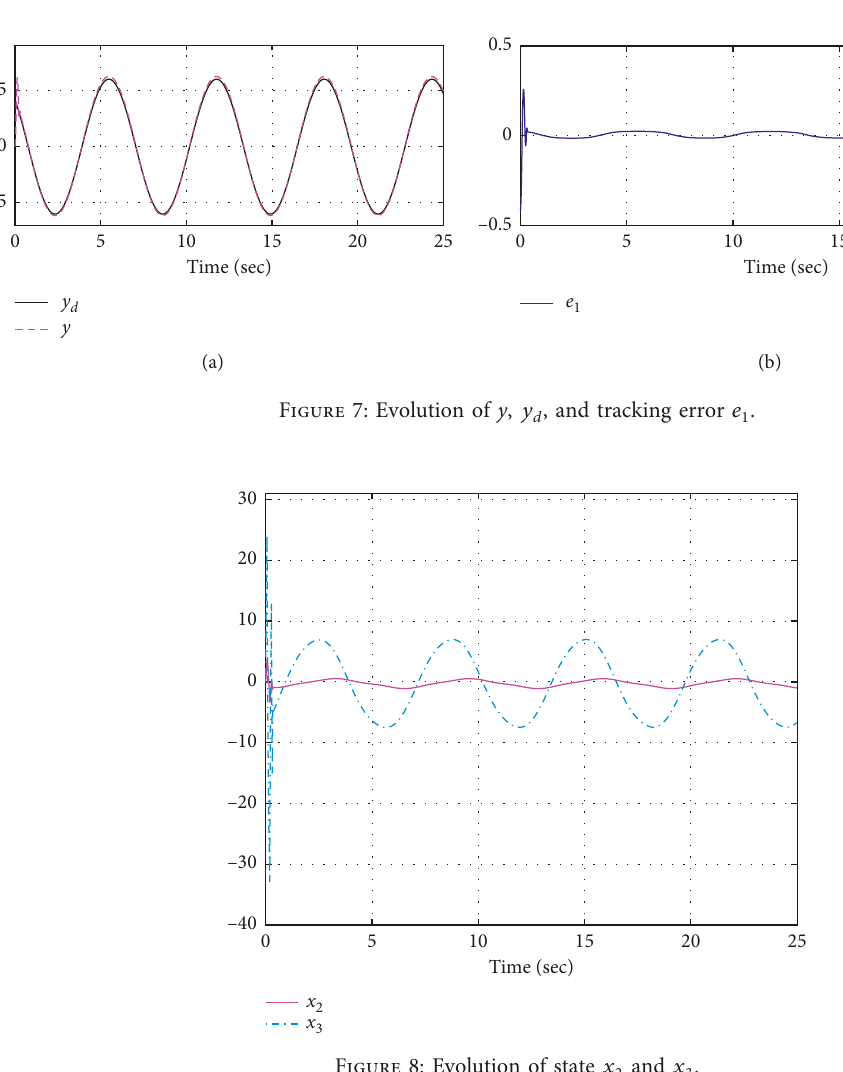
Figure 8: Evolution of state x